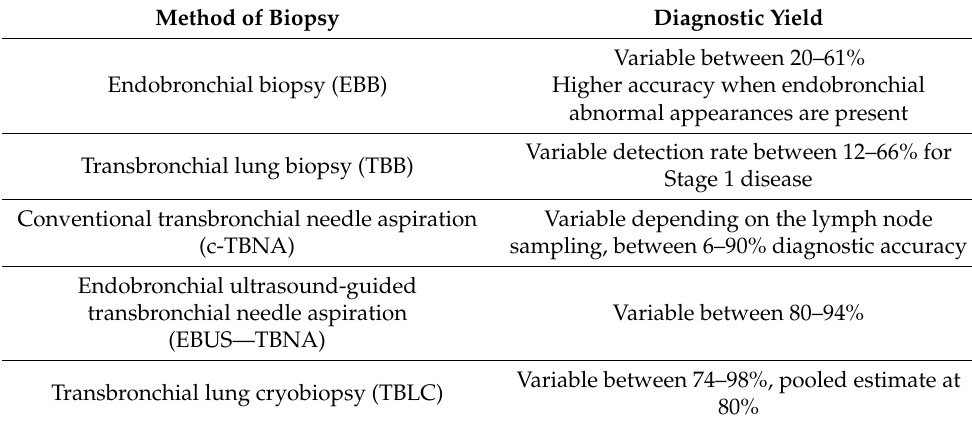
Table 5. Diagnostic biopsy yield in different fiberbronchoscopic techniques [25]. Method of